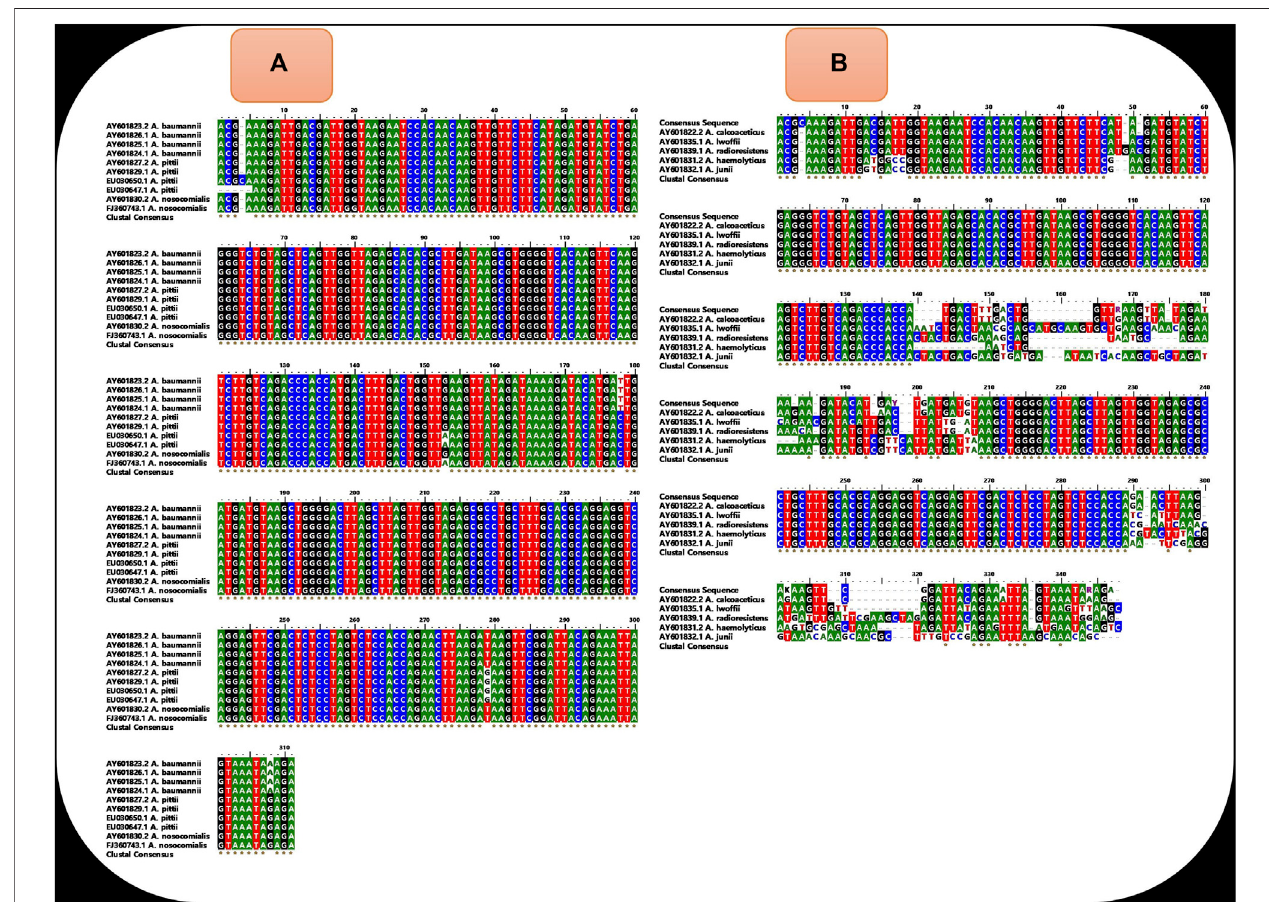
FIGURE 2 | (A) shows the alignment of sequence of diverse isolates of A. baumannii ( N (cid:2) 4), A. pittii ( N (cid:2) 4), and A. nosocomialis (N (cid:2) 2) and demonstrates that the sequencesareconservedacrossdiverseisolatesofthreespeciesexceptfewlocations. (B) showsthealignmentofourconsensusITS16S – 23SrRNAsequencewiththe sequence of other Acinetobacter species ( A. calcoaceticus , A. lwof fi i , A. radioresistens , A. haemolyticus , and A. junii ). The presence of the non-conserved region at locations from 140 to 210 (where our two to three primers are aligned) demonstrates that our LAMP primers were not speci fi c for other Acinetobacter